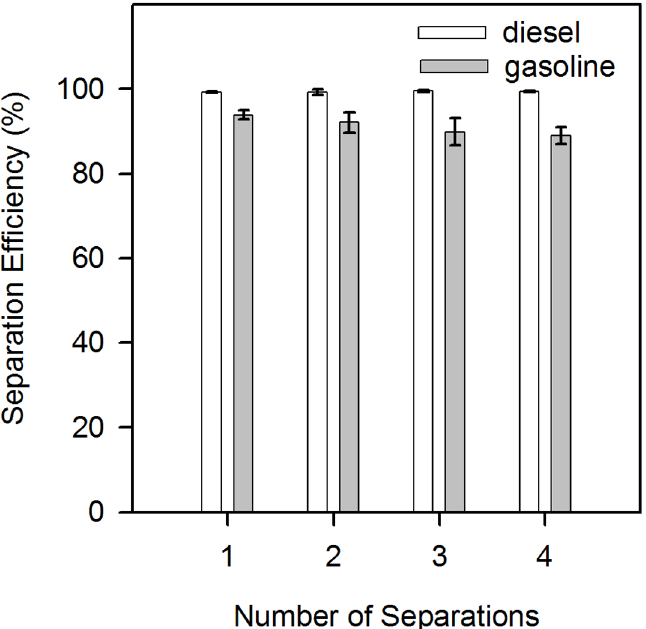
Fig 6. Relationship between separation efficiency of oil/water mixtures and the number of separations on a single sheet of silanized filter